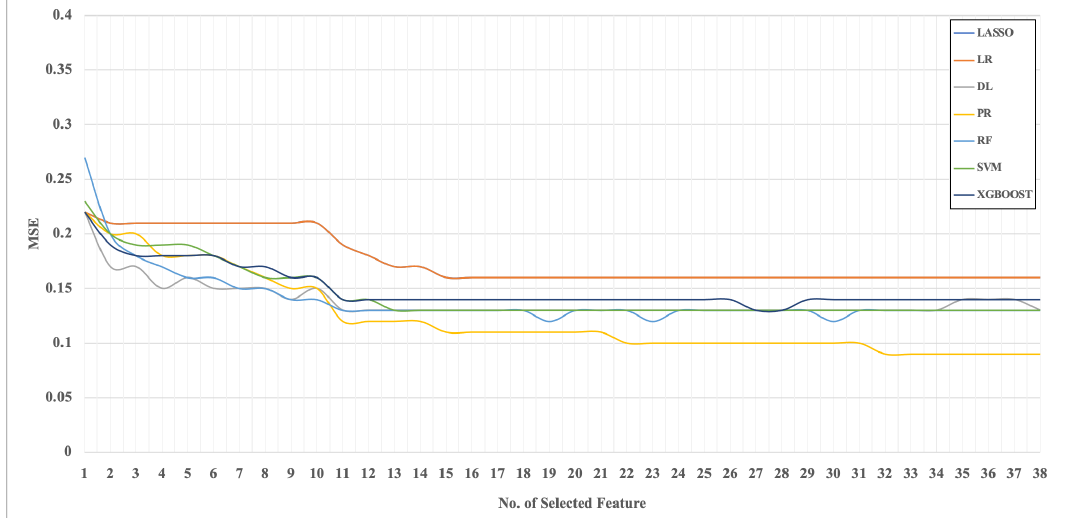
Figure 8. Results attained with various ML